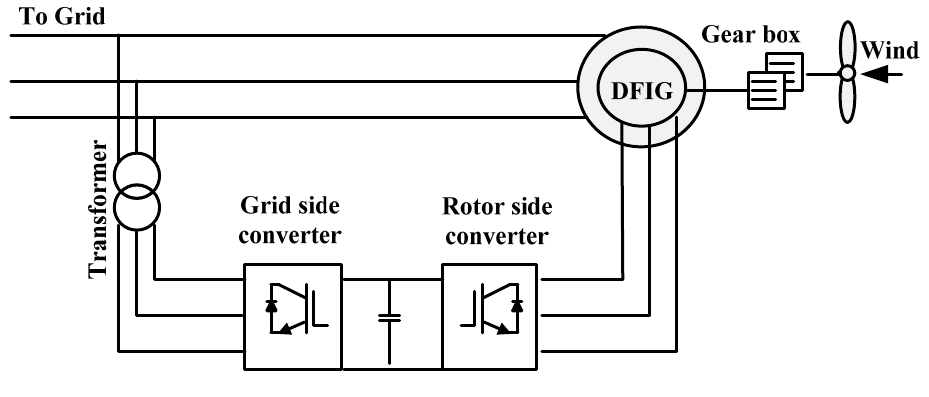
Figure 1. DFIG configuration.